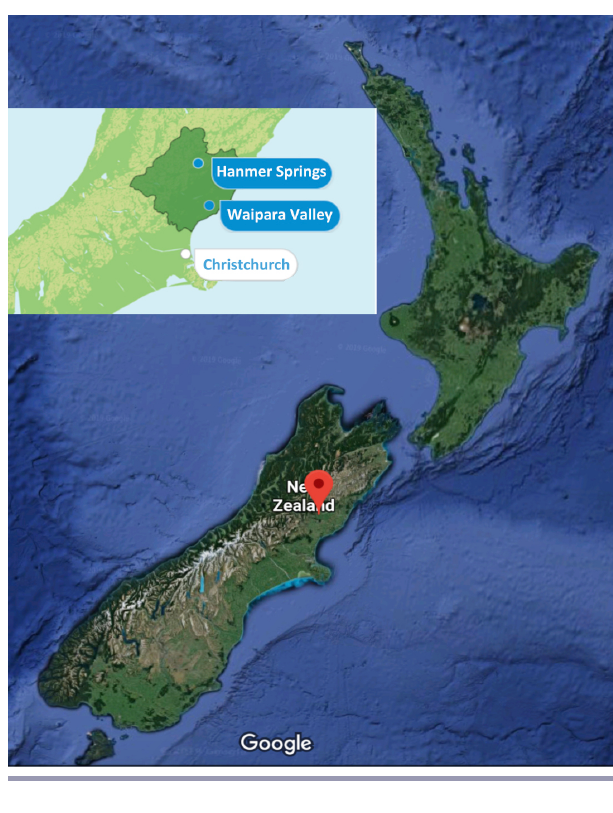
Fig. 2 . Study area location (Google Maps/https://visithurunui. co.nz/ 2019).